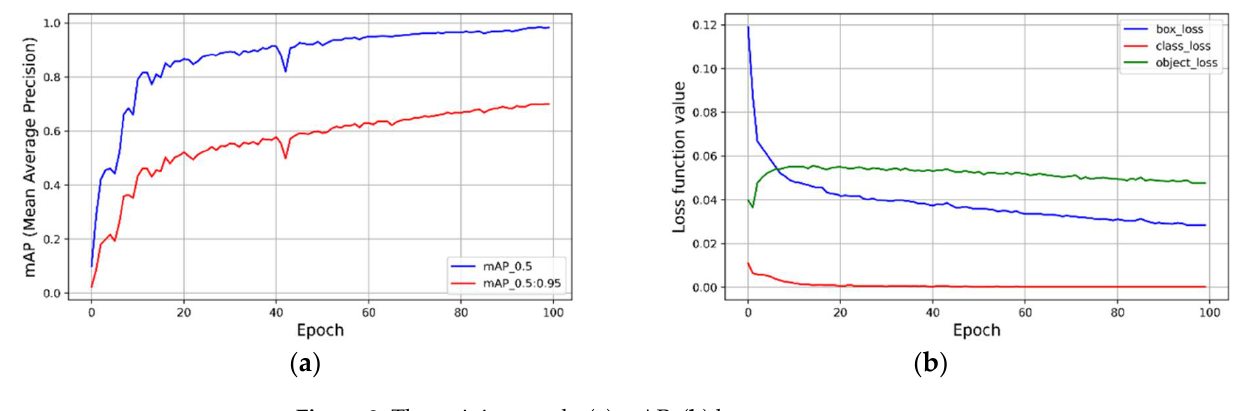
Figure 8. The training result: ( a ) mAP; ( b ) loss. Table 3. The training results of each version of the YOLOv5 model on the original dataset. Method